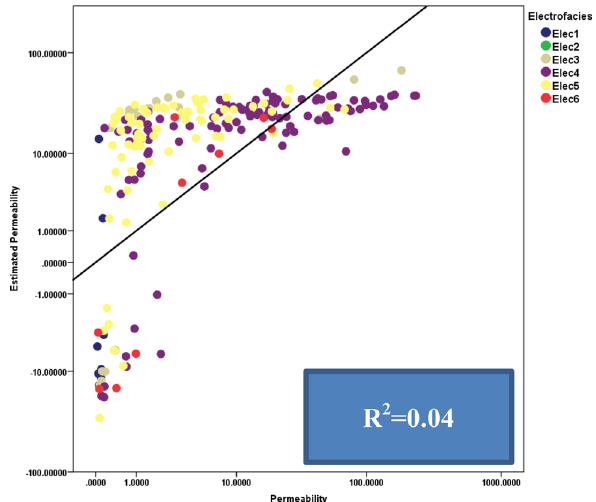
Fig. 24 Cross plot of results from estimated permeability by linear regression model versus core permeability